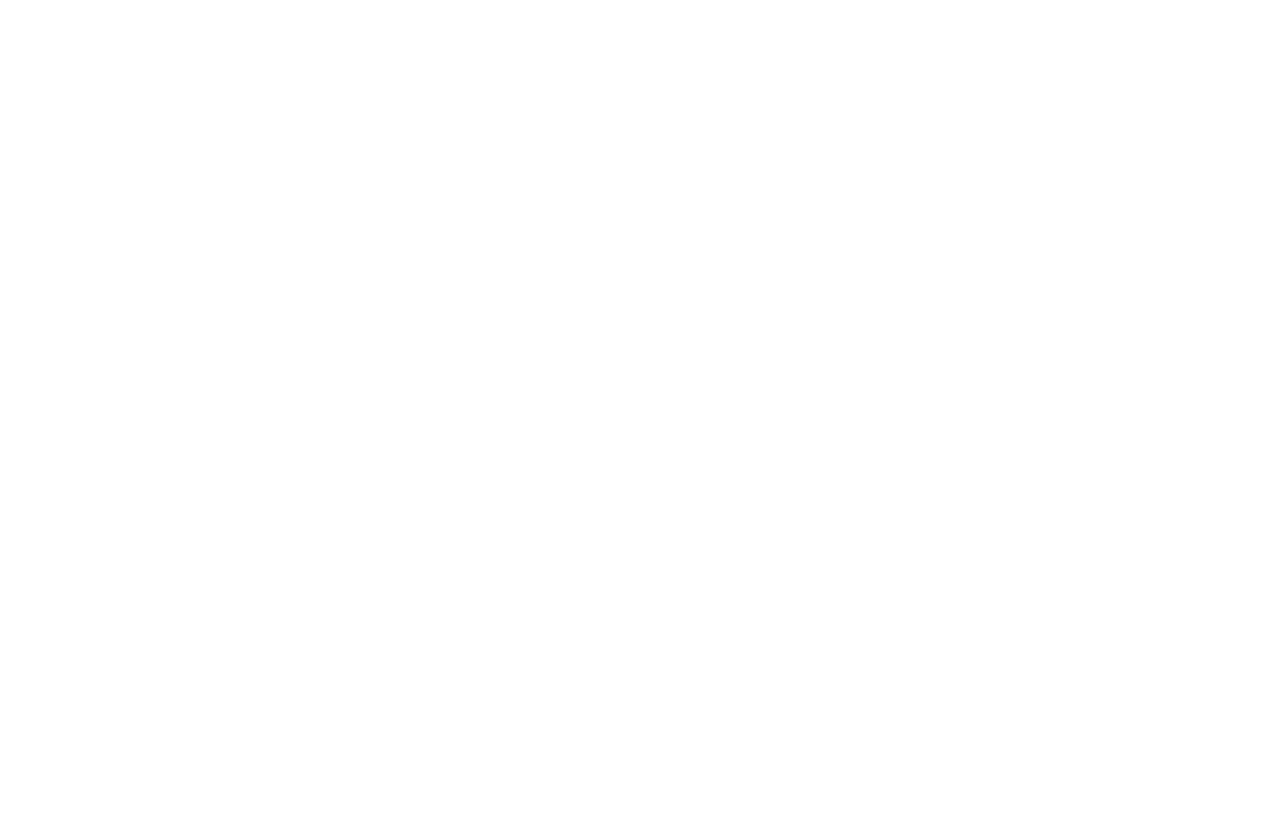
by white and blue triangles, respectively.The number of repeated units inside each block is indicated below.The three khipu of the first block are detailed with their names indicated below.These are khipu phylogenetically clustered with three khipu of the BAC contig PvA05A presented in FigureA1